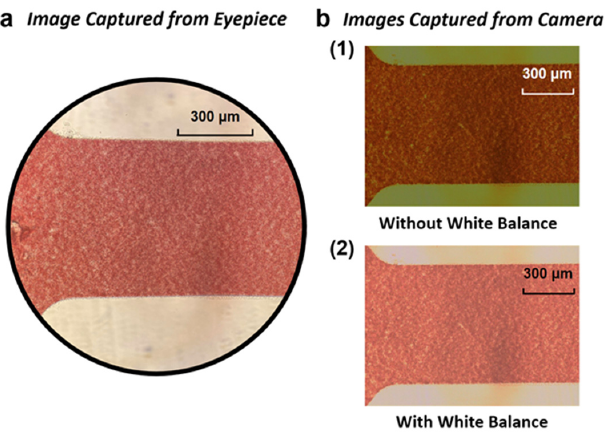
Figure 3. Comparison of images captured during the flow of blood with 15% hematocrit in the microchannel ( a ) from the eyepiece of the microscope and ( b ) from the camera (1) before white balance and (2) after white balance.